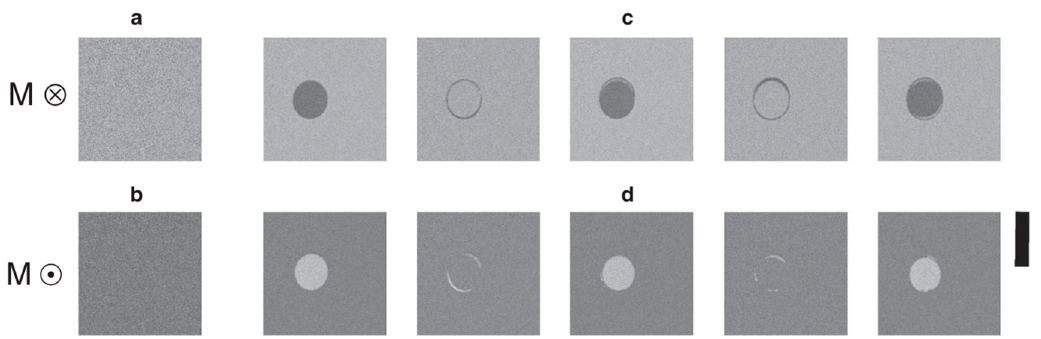
Figure 13. The magneto-optical images of a Gd 24 Fe 66.5 Co 9.5 continuous film obtained after the action of a sequence of N 100 fs laser pulses. ( a , b ) Initial homogeneously magnetized state of the film with magnetizations ‘up’ and ‘down’ as represented by the circled dot and cross, respectively. The light grey region represents magnetization pointing ‘down’ and the darker grey ‘up’. ( c , d ) The film after excitation with N (N = 1, 2…5) pulses with a fluence of 2.30 mJ·cm − 2 . Each laser pulse excites the same circular region of the film and reverses the magnetization within it. The scale bar on the right corresponds to 20 µm. Reprinted with permission from ref. [105] 2012 Springer Nature.